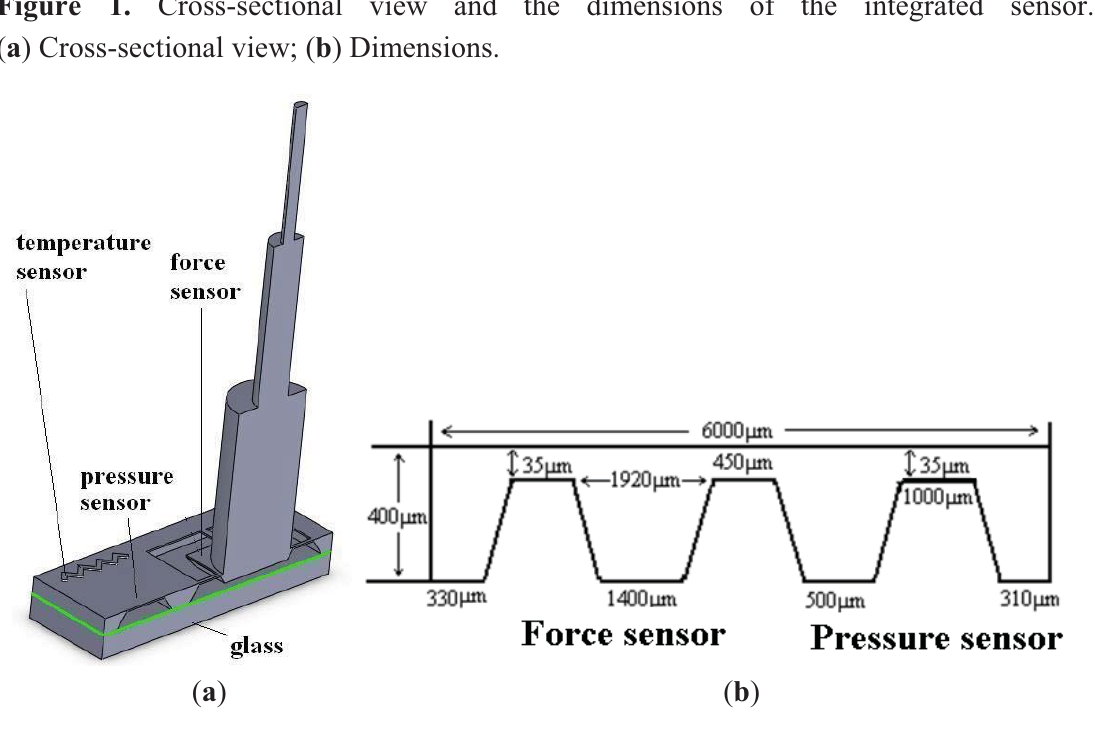
Figure 1. Cross-sectional view and the dimensions of the integrated sensor.